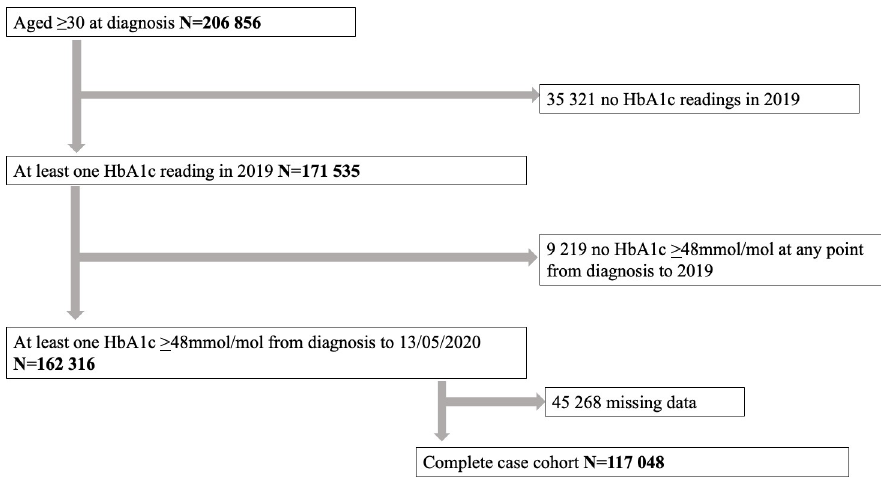
Fig 1. Flow diagram showing the number of individuals with type 2 diabetes diagnosed in Scotland between January 1, 2004 and December 31, 2018 who were alive on December 31, 2019 and were registered with a Scottish health board who were eligible for inclusion in descriptive analyses/multiple imputation analysis and complete case analysis.